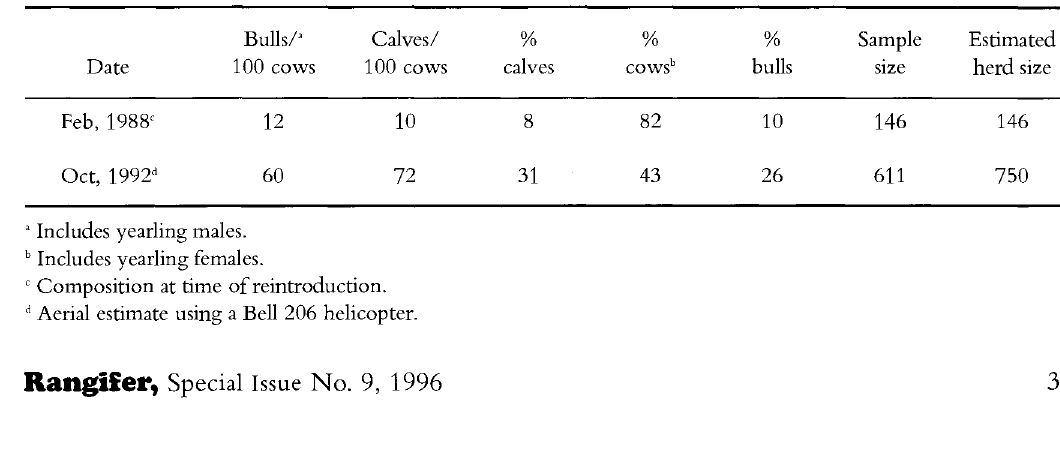
Table 1. Sex and age composition of the Nushagak Peninsula caribou herd, southwest